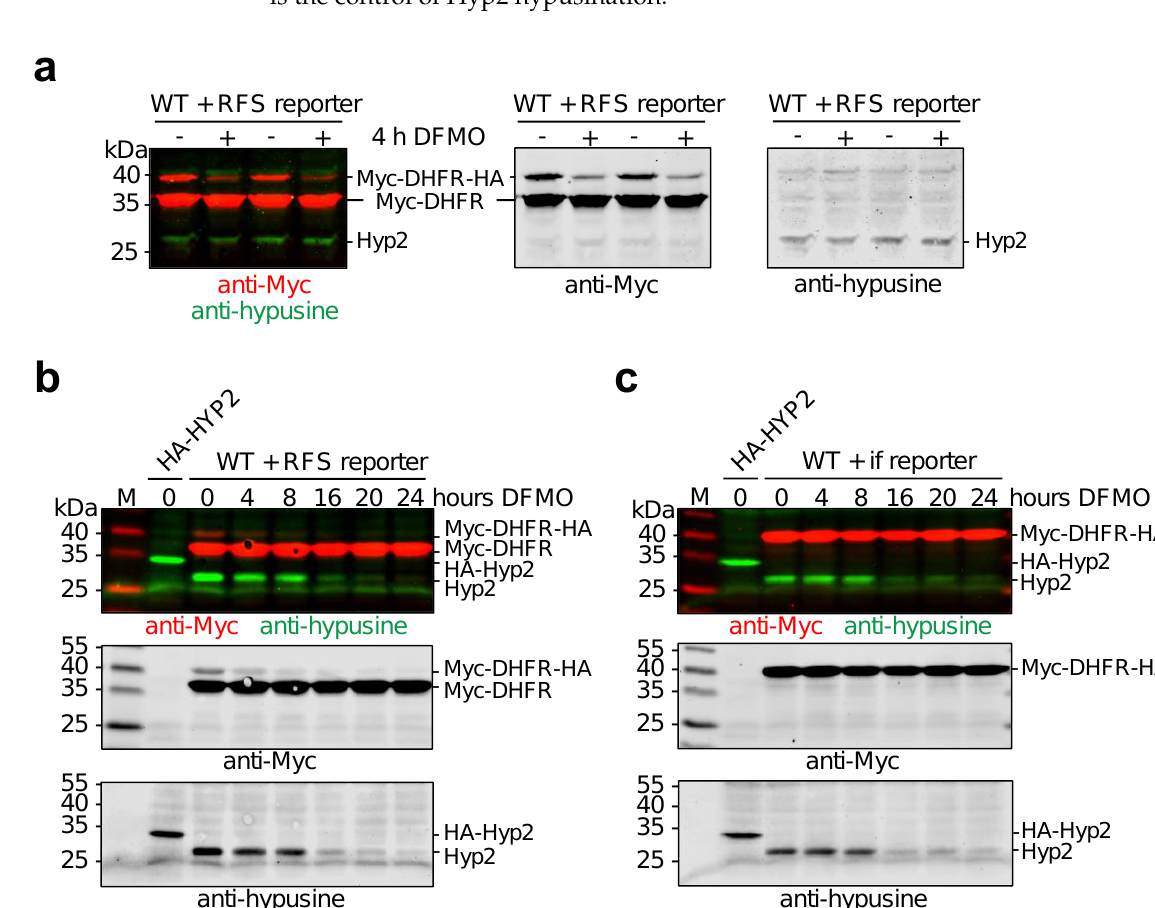
Figure 5. Polyamine depletion inhibits ribosomal frameshifting earlier than affecting Hyp2 hypusination ( a ) Western blot analysis of RFS reporter and hypusinated Hyp2 levels. Two independent spore clones of wild-type (WT) cells expressing the RFS reporter were grown in synthetic SD media and incubated either with or without 5 mM DFMO for four hours. ( b ) Same as in ( a ), except that DFMO was added at time point 0, and samples were taken after the indicated times for up to 24 h later. ( c ) Same as in ( b ), except that the cells expressed the in-frame (if) reporter. Extract proteins were analyzed by SDS-PAGE and western blotting with simultaneous detection of Myc (red) and hypusine signals (green). Grayscale panels separately show the signals detected with the individual antibodies. Positions of the relevant polypeptides and the size markers (M) are indicated.